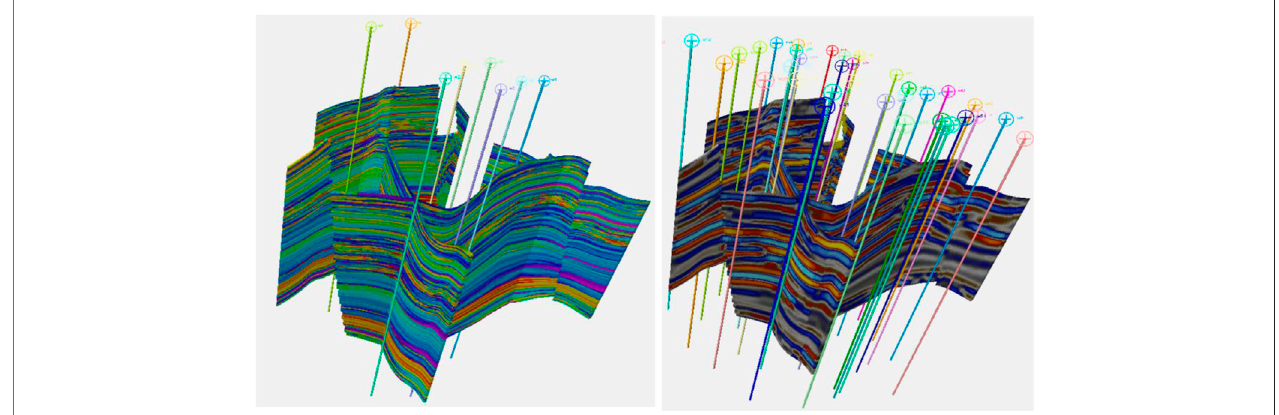
FIGURE 1 | On the left, the true porosity of the reservoir to be modeled is shown. On the right, a synthetic RAI volume created is shown. The locations of the fi rst eight wells are shown on the left, while the thirty-six-well case is on the right.